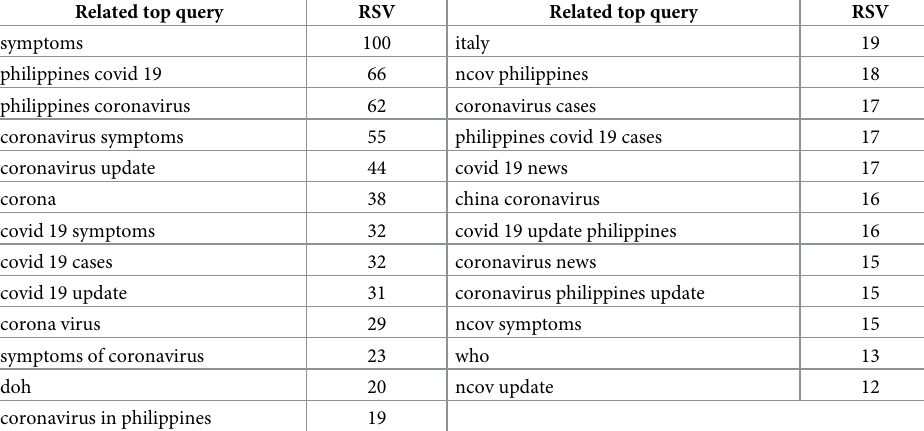
Table 1. Related top queries and search interest value for COVID-19 terms. Related top query